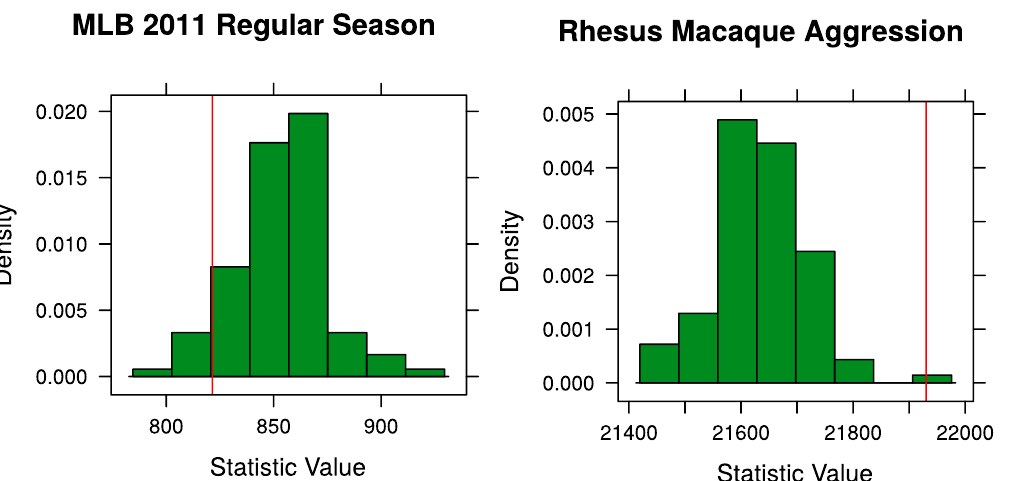
Fig. 4. Results of the systemic test for real data examples. Panel (a) shows that there is no significant evidence to show that the MLB teams violate the Bradley-Terry assumption. The results in Panel (b) show the systemic test verifies that the complicated structure of the rhesus macaque society cannot be modeled accurately by the Bradley-Terry